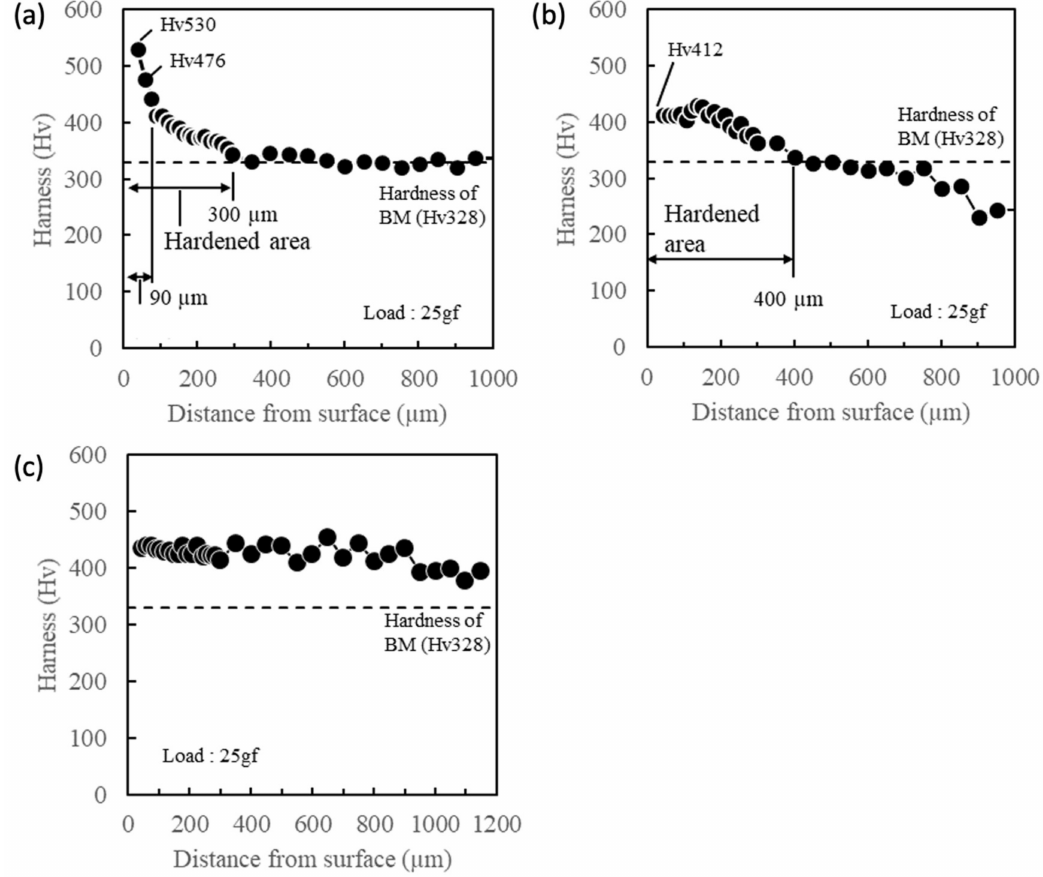
Figure 5. Vickers microhardness distribution through the thickness direction ( a ) sample A for low peak temperature; ( b ) sample B for mid peak temperature; and ( c ) sample C for high peak